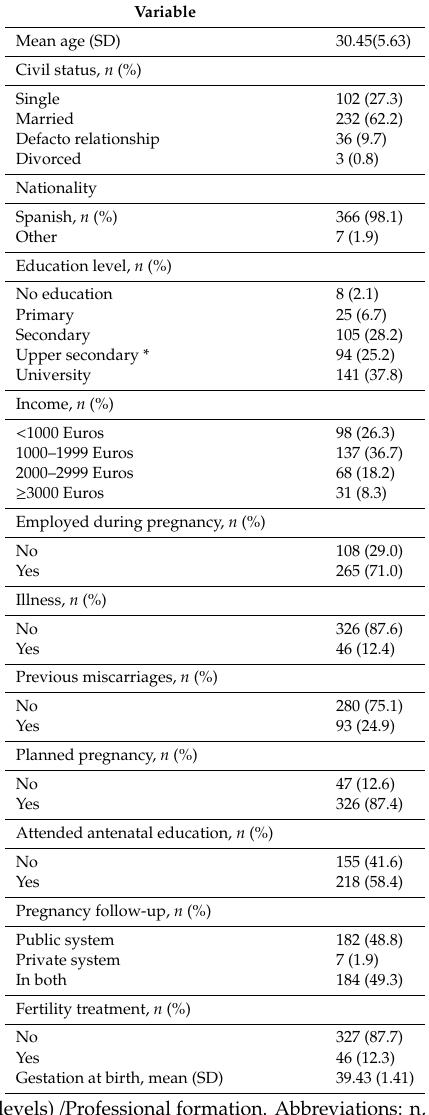
Table 1. Characteristics of the study